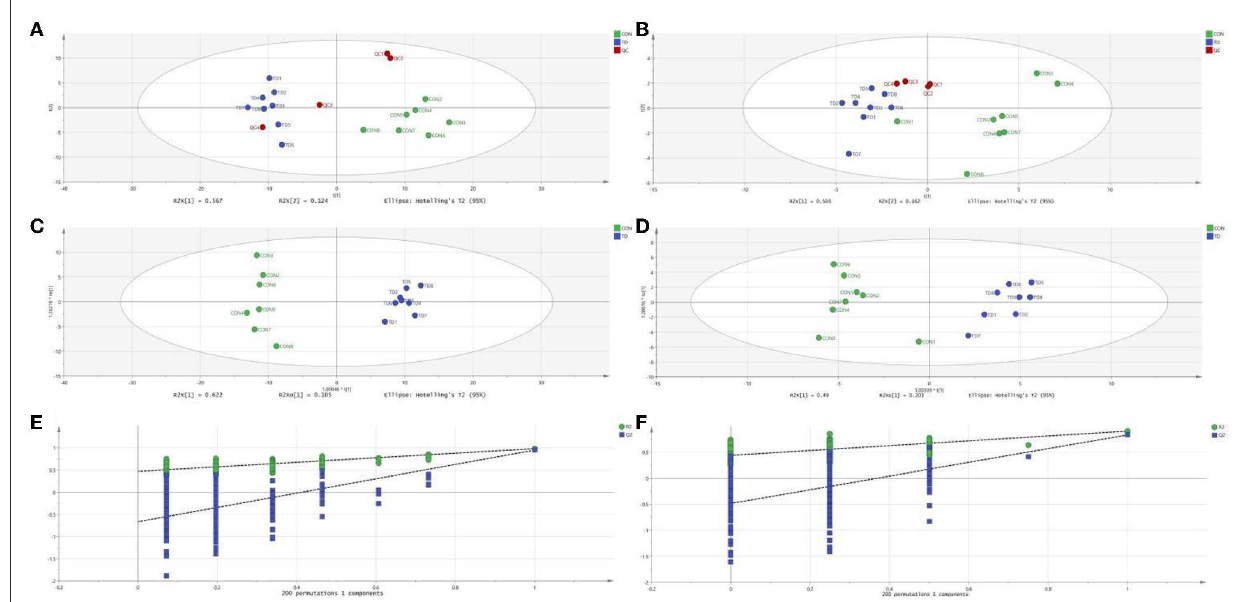
FIGURE1 Thiram exposure altered liver metabolism. (A, B) PCA score plots based on positive-ion mode and negative-ion mode, respectively. (C, D) OPLS-DA plot based on positive-ion mode and negative-ion mode, respectively. (E, F) Permutation tests based on positive-ion mode and negative-ion mode,